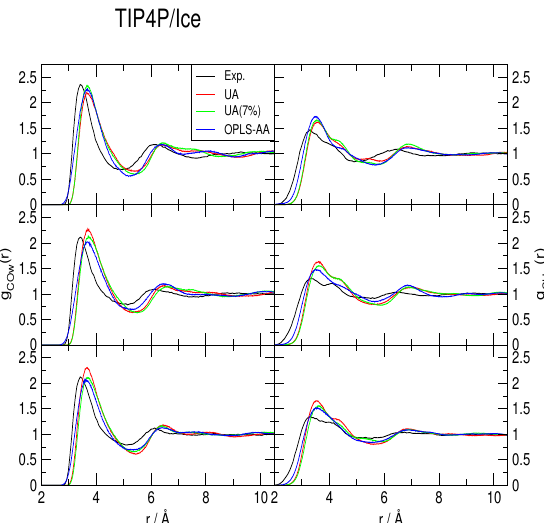
Figure 3. Comparison to the experimentally determined [34] methane-water radial distribution functions of those obtained from simulations with the TIP4P/Ice water model at 277 K ( top ), 283 K ( middle ) and 291 K ( bottom ), all under a pressure of 145 bar. UA: United-atom model from Reference [41]; UA (7%): Same model with a 7% correction for the C − O interaction; OPLS-AA: All-atom force-field from Reference [40].